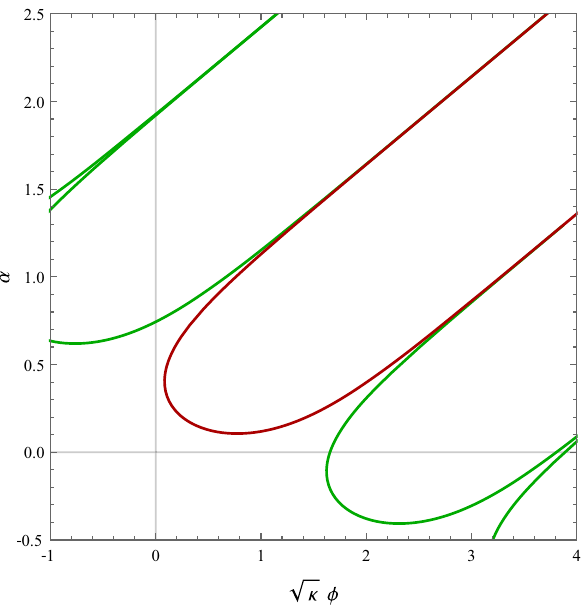
Fig. 1 Multiple solutions contained in Eq. (42) for (cid:13) = 1, V = 1, λ = 2 and A 2 = 160 / 3. Only one of them is physical, which can be taken to be the red one; the other trajectories (in green) appear due to the ambiguity in the timeless Eq. (42). If a time parameter is chosen, the other branches will